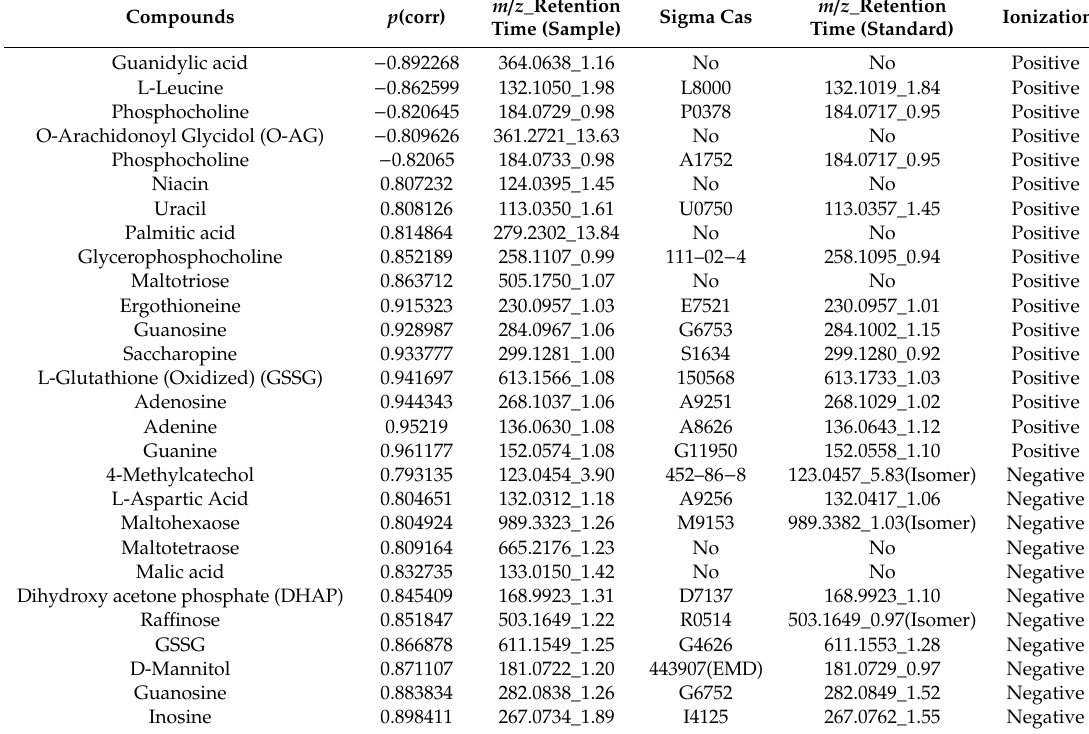
Table 1. Compounds identified by HPLC-MS / MS analysis from healthy ants compared with Ophiocordyceps unilateralis -infected ants.